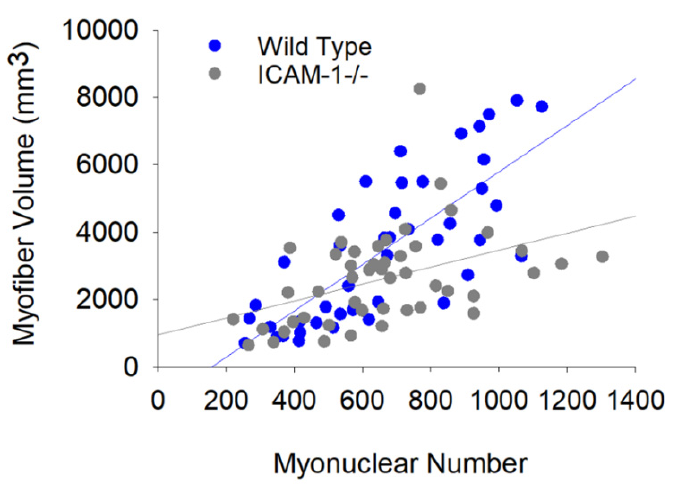
Figure 3. The relationship between myonuclear number and myofiber volume in Wild Type and ICAM-1-/- mice during injury-induced muscle regeneration. The scatter plot and regression lines display the number of myonuclei and corresponding myofiber volume (mm 3 ) within a segment for 7–28 days post-injury. Data and regression line for Wild Type mice (r = 0.77; Myofiber volume = 0.66 × number of myonuclei − 88.0; n = 44 myofibers) and ICAM-1-/- mice (r = 0.43; Myofiber volume = 0.25 × number of nuclei + 99.2; n = 48 myofibers).